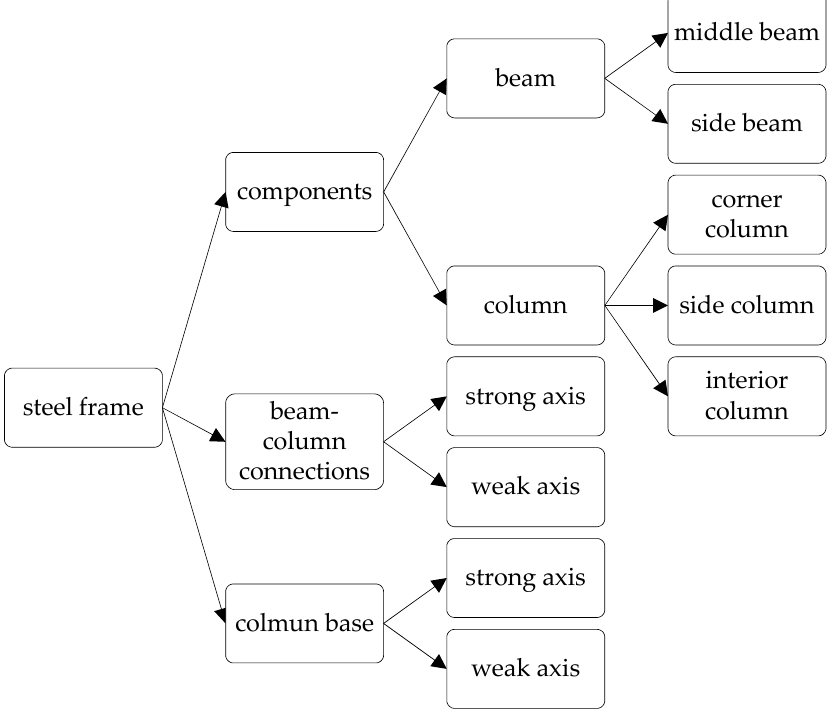
Figure 2. Schematic diagram of component and joint grouping.